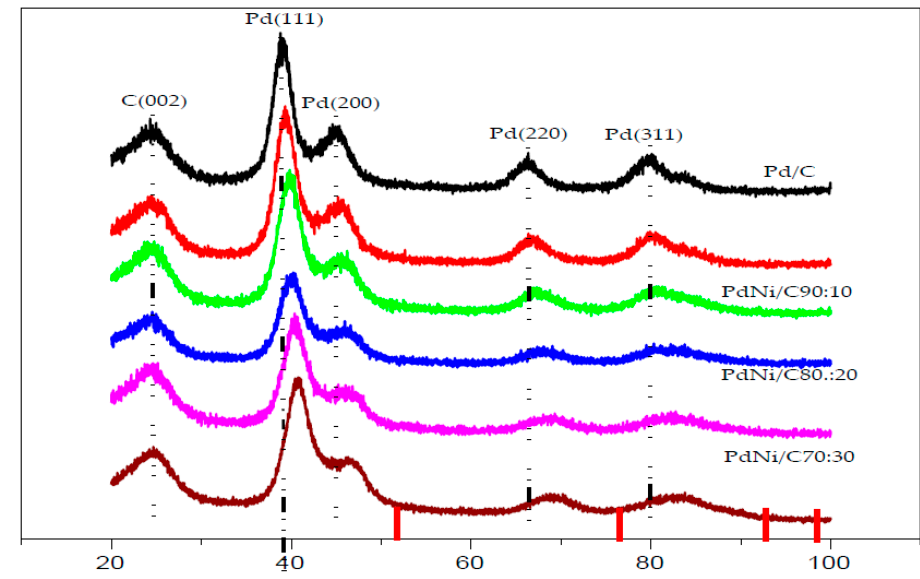
Figure 1. X-ray diffraction data for carbon-supported Pd and PdNi/C catalysts.